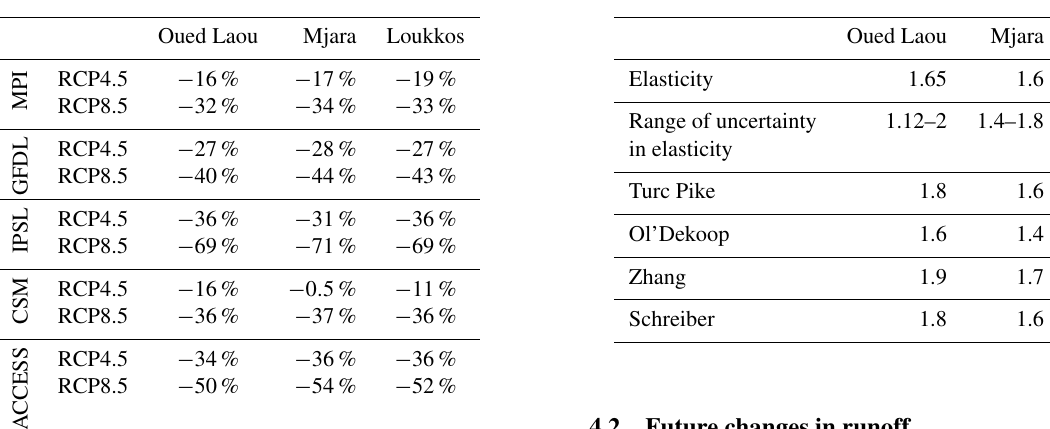
Table 5. A summary of the potential changes in precipitation fol- lowing the RCP4.5 and RCP8.5 simulations with MRCM for the five different GCMs’ forcing.